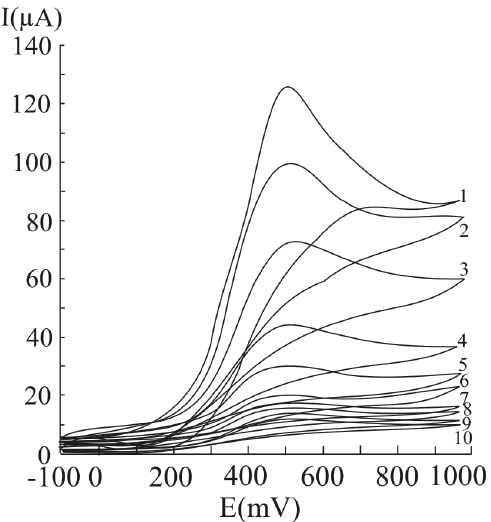
Figure 9. Cyclic voltammograms obtained with a carbon paste working electrode for different ascorbic acid concentrations, expressed as mM: 20 (1), 15 (2), 10 (3), 5 (4), 2.5